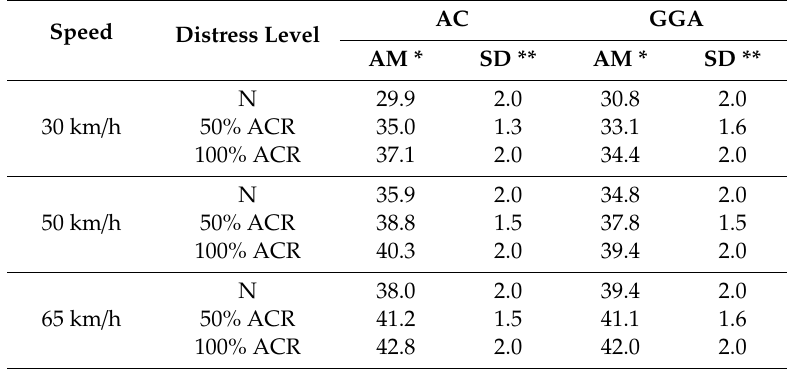
Table 5. Noise levels [dBA] by speed and distress level for AC and GGA. Speed